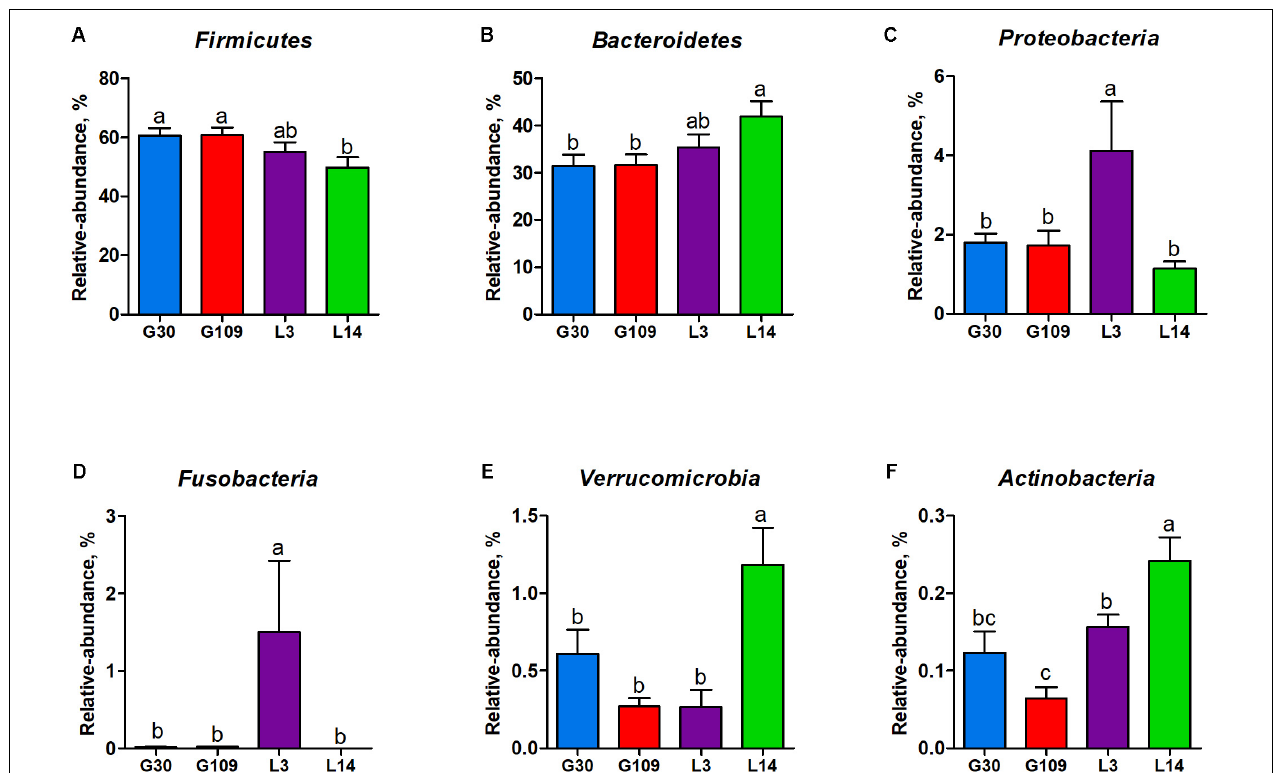
FIGURE 2 | Changes in the five distinct bacterial phyla in sow gut across the reproductive cycle. (A) Firmicutes, (B) Bacteroidetes, (C) Proteobacteria, (D) Fusobacteria, (E) Verrucomicrobia, and (F) Actinobacteria. Data are presented as means ± SEM ( n = 12). a–c, significant effect of sampling day ( P < 0.05; values with different lowercase letters are significantly different). G109, day 109 of gestation; L3, day 3 of